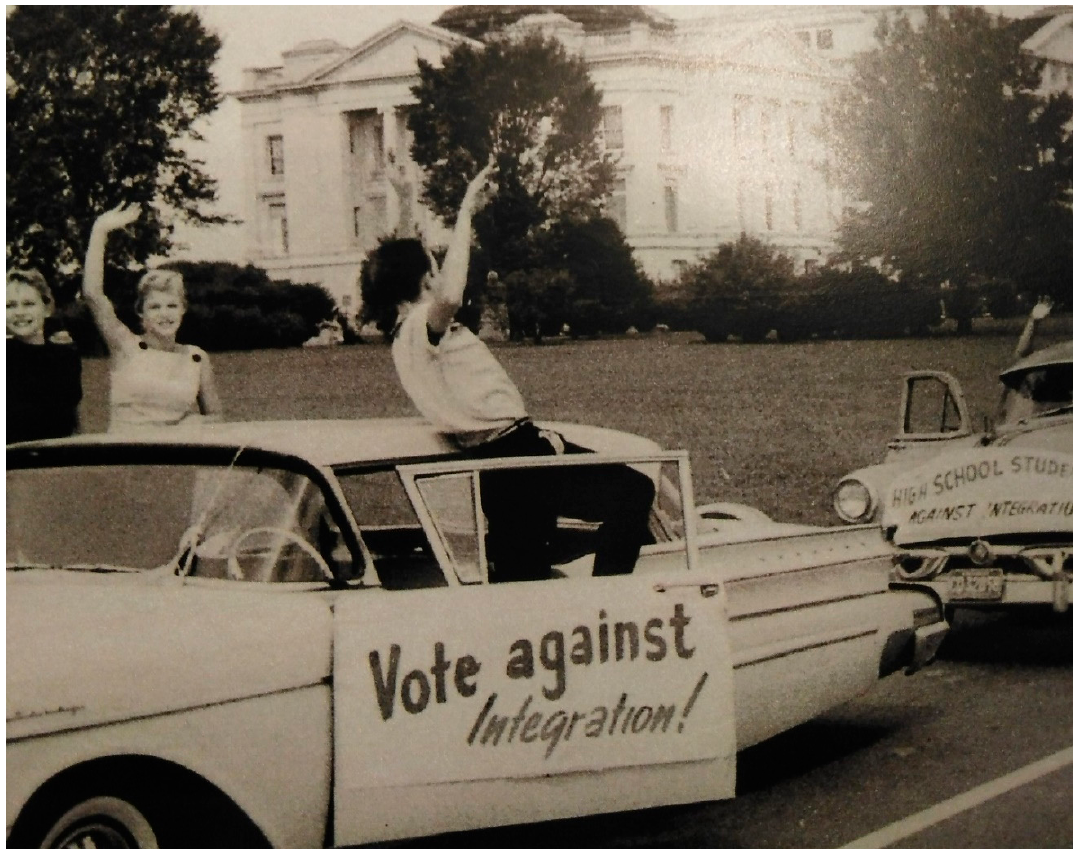
Figure 2. In 1954 the United States Supreme Court ruled segregation in public schools to be unconstitutional in the Brown v. Board of Education case, acknowledging that racially separate schools were inherently unequal. Despite the sentence, the huge backlash against integration by some whites in the south led President Eisenhower in 1957 to dispatch federal troops to protect 9 Black students attending the recently desegregated Central High School in Little Rock, Arkansas. While the civil rights movement of the 1960s and 1970s achieved significant gains in integration, there has been backsliding since in both education and housing segregation (picture from 1957, Little Rock, Arkansas).